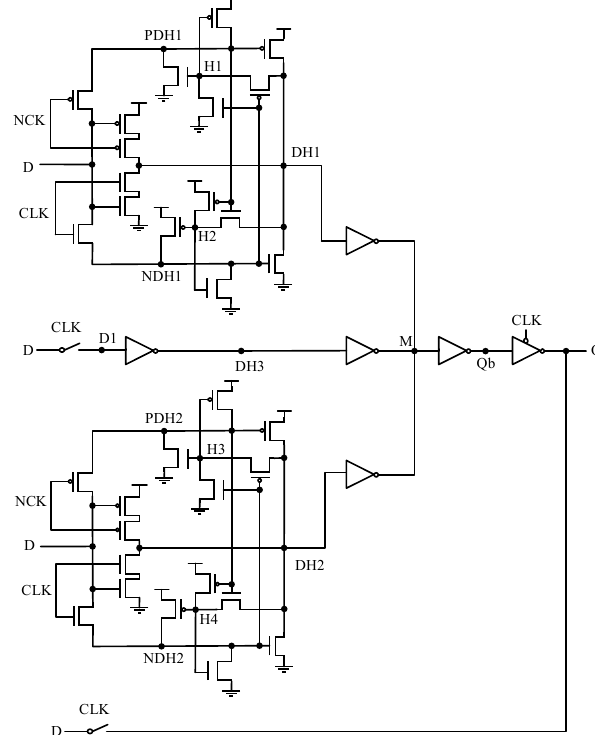
Figure 4. Latch schematic for LOCTNUTRL.